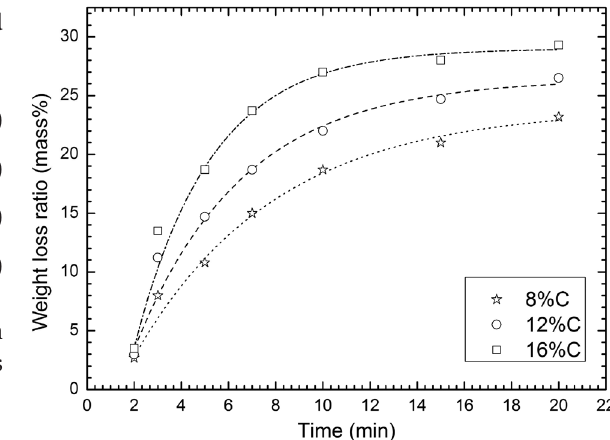
Fig. 5: The relation between the weight loss ratio with heating time